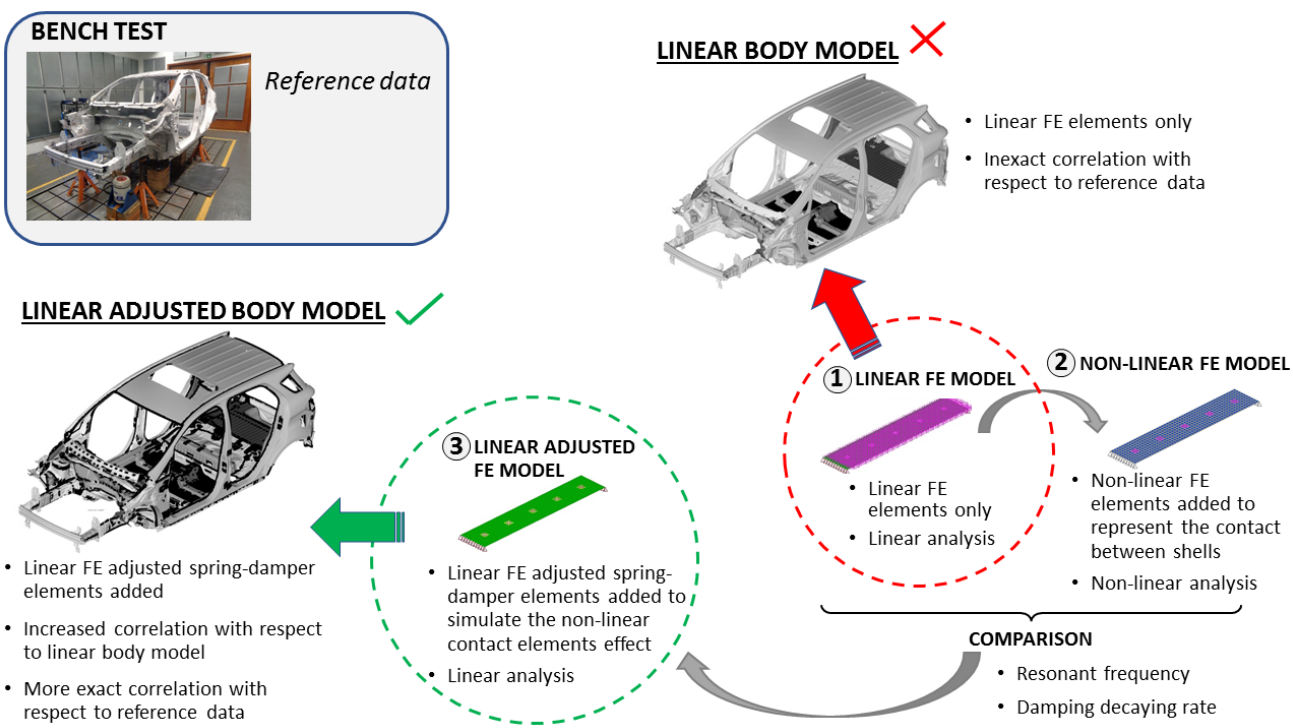
Figure 1. Scheme followed to develop the adjusted linear FE model of the vehicle body structure. After that, we built three FE test models to represent a small part of the structure welded flange. We first built an FE test model using only linear parameters, thus avoiding nonlinear behaviours in the contact area between the flanges of adjacent panels. We then built a second nonlinear FE test model using the first model as a base, adding to the first model the nonlinear contacts of the flanged areas and computed the difference of behav- iour between both models. We also built a third linear FE test model using the first model as a base but now adding linear spring-damper elements to simulate the nonlinear behav- iour at the contact areas. The elastic constants of these spring-damper elements were ad- justed using the differences found between the responses of the first and second FE mod- els. We finally built an adjusted FE model of the whole vehicle body structure, adding to the reference FE model of the body structure the linear spring-damper elements previ- ously adjusted with the help of the FE test models. We then performed with this adjusted model the same analyses carried out with the bench test and the reference FE model, com- paring the adjusted model results with the bench test results, and computing the correla- tion coefficients. The results of the adjusted FE model of the body structure showed an improvement of 10.6% in the correlation coefficient, compared to the results of the initial reference model. The modal behaviour coefficients and the visual comparison of the FRF curves also show a higher correlation given by the adjusted model, confirming the validation of the adjustment methodology proposed here. During the state-of-the-art review, we detected a knowledge gap regarding the rep- resentation of nonlinear contacts in large finite element models subjected to frequency domain analysis. To overcome this gap, the objective of this work is to find a new ap- proach to model spot-welded flanged joints into linear finite element models of thin-wall vehicle body structures, using a nonlinear model behaviour as a reference. In this way, we could improve the accuracy of the modal and frequency response function results without increasing the complexity of the FE model analysis.